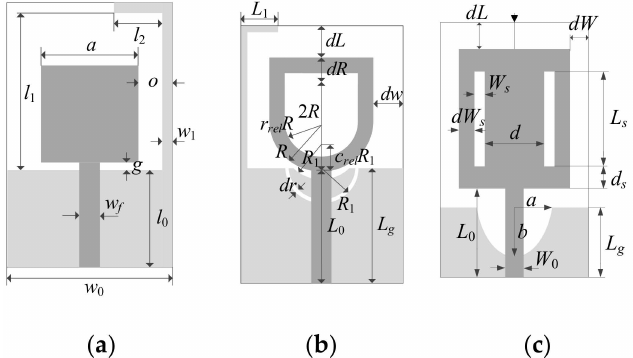
Figure 3. Benchmark antennas for verification of the proposed optimization algorithm: ( a ) Antenna